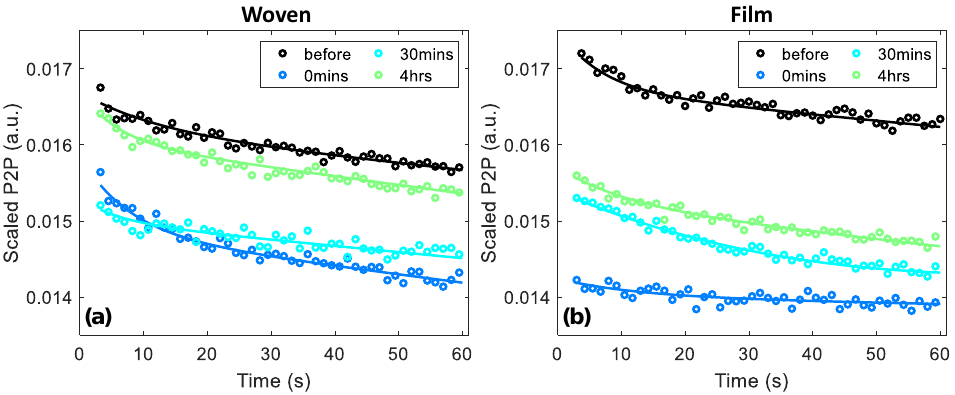
Figure 6. An example of the occlusion curves observed for a single subject following the application of ( a ) woven-backed and ( b ) film-backed patches; every fifth data point was plotted and the bi- exponential fits are shown by the solid lines. The results have been scaled by subtracting the change in the control region between the initial measurement and the measurement taken at that time point.